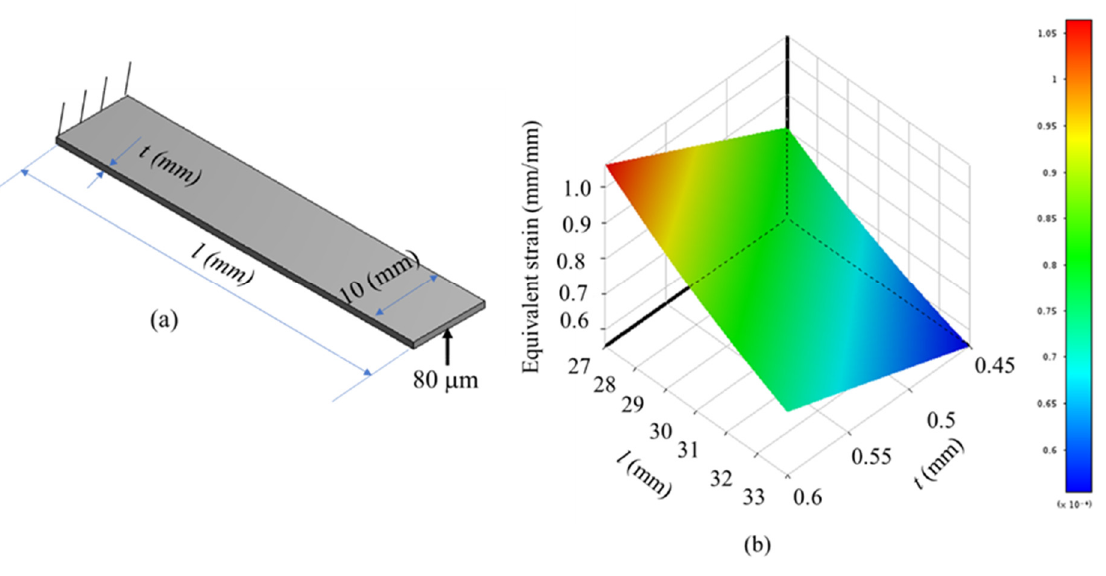
Figure 11. Influence of thickness and length of leaf hinge to the strain: ( a ) dimension of leaf hinge and ( b ) 3D plot.